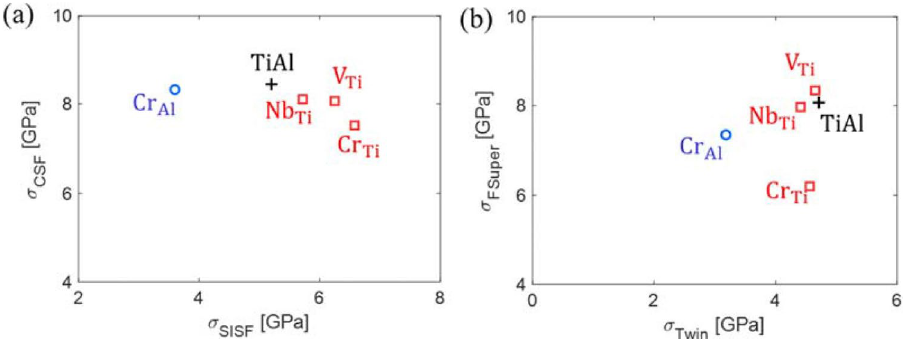
Figure 7. (a) ICRSSs of the SISFs and CSFs. (b) ICRSSs of twinning and forward super slip (X Ti : substitution in a Ti site, X Al : substitution in an Al